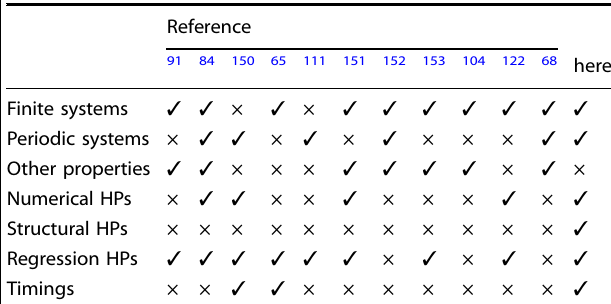
Table 2. Related work. See Supplementary Note 5 for details.